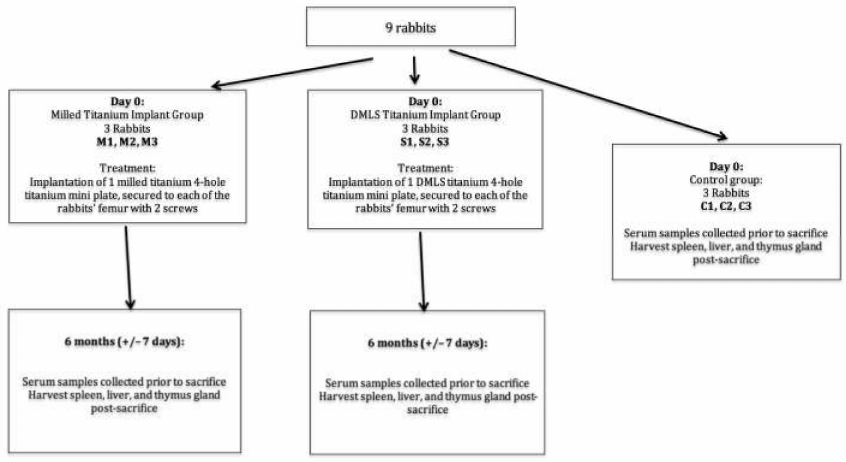
Figure 4. Schematic diagram of rabbit